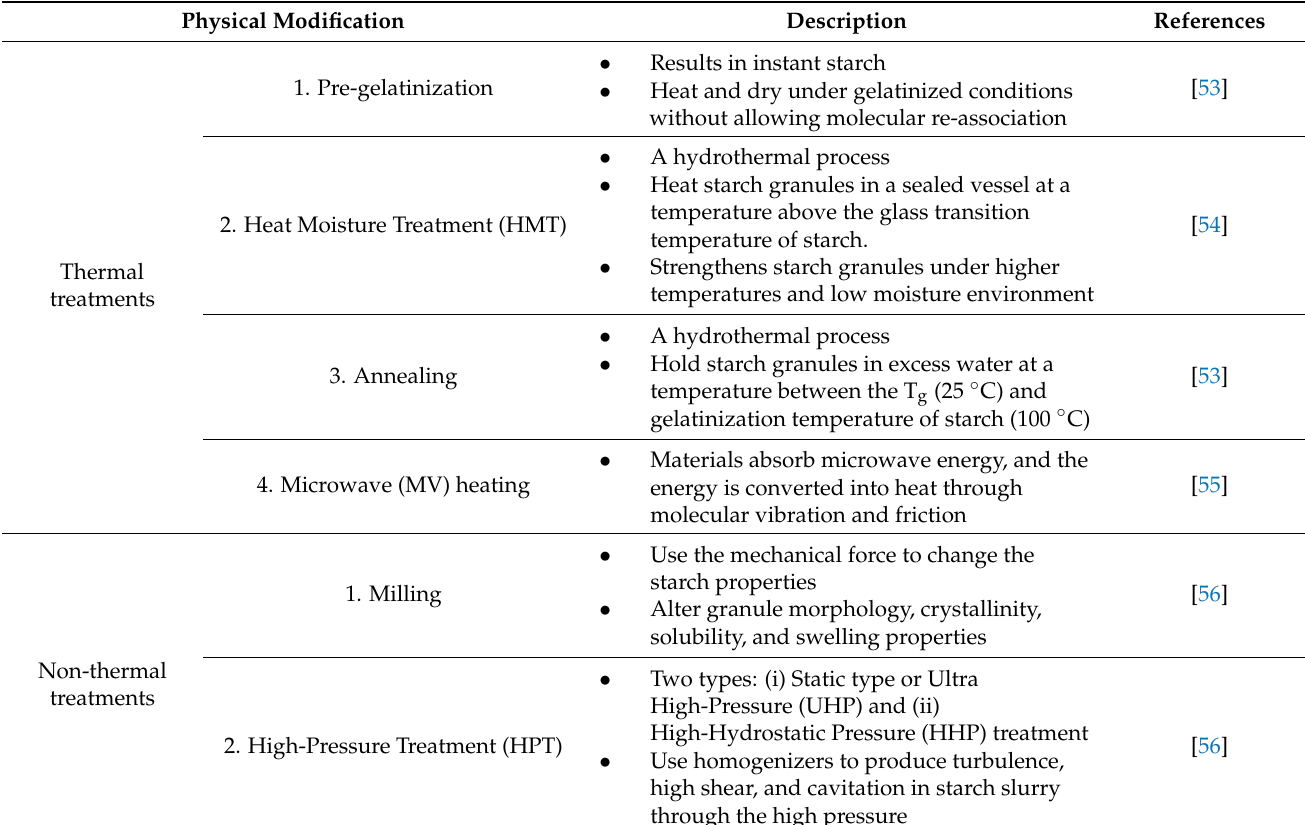
Table 3. A summary of physical starch modification